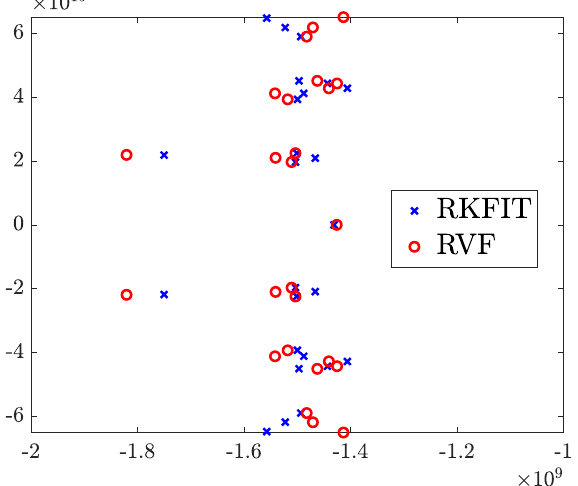
Figure 9. RKFIT and RVF